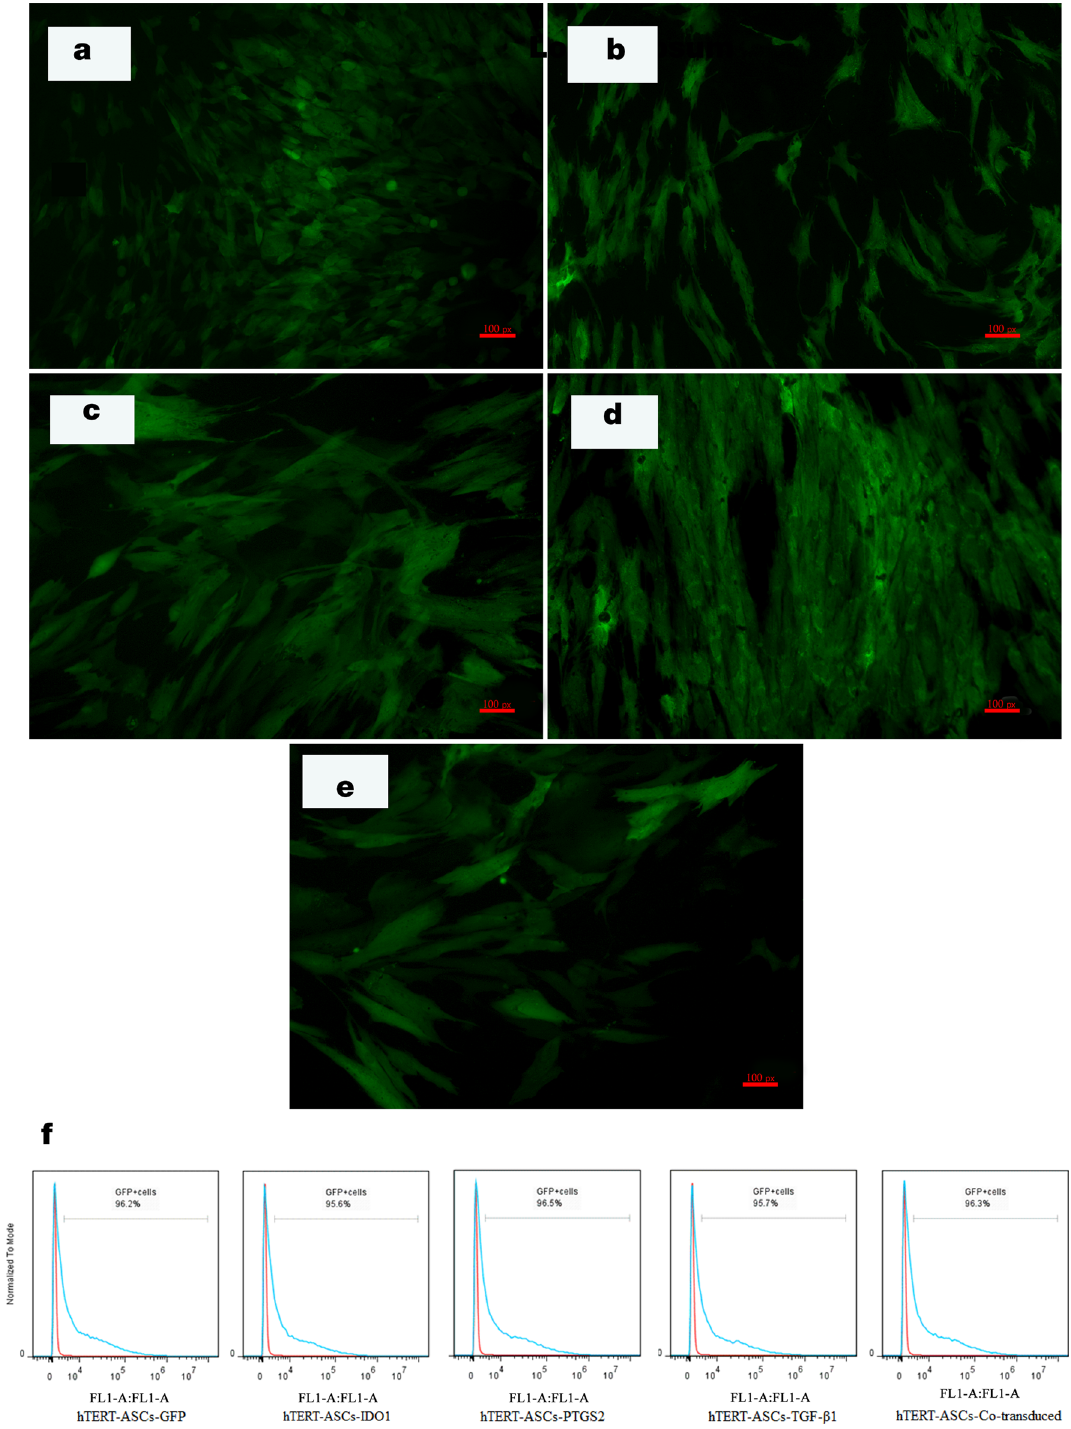
Figure 2. Transduction of hTERT-MSCs with target genes. Fluorescence microscopy analysis of modified hTERT-MSCs ( a – e ) represents transduction with GFP , IDO1 , PTGS2 , and TGF - β1 target genes in addition to transduction with combinatorial viral particles (co-transduced group), respectively (Nikon, Japan, scale bars represent 100 pixel). ( f ) Efficiency assessment of gene transfer into hTERT-MSCs for GFP , IDO1 , PTGS2 , TGF - β1 or co-transduced cells as evident by flow cytometric detection of green fluorescent protein (Data were obtained by BD Accuri C6 and analyzed using FlowJo Software version